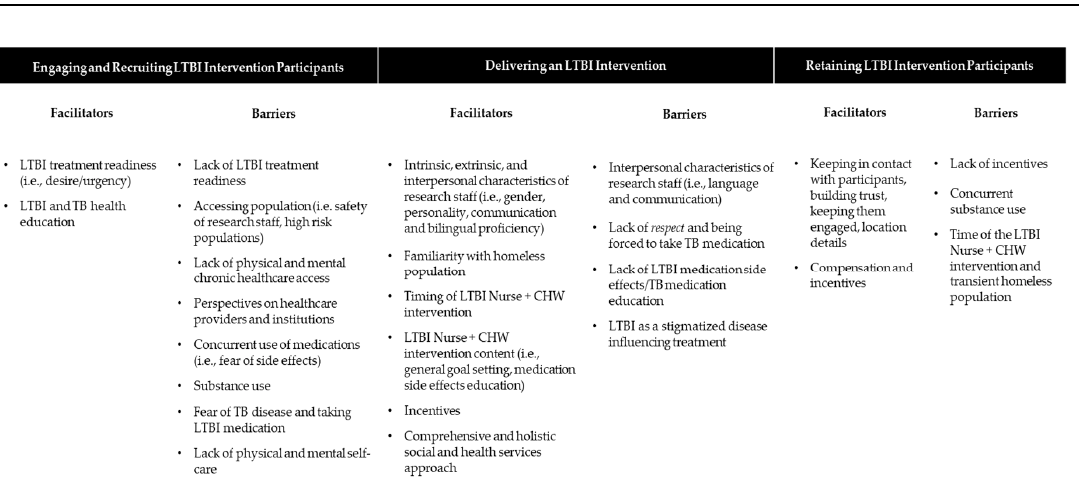
Figure 1. Qualitative themes and subthemes of nurse led, CHW LTBI adherence model for homeless adults (N = 11).